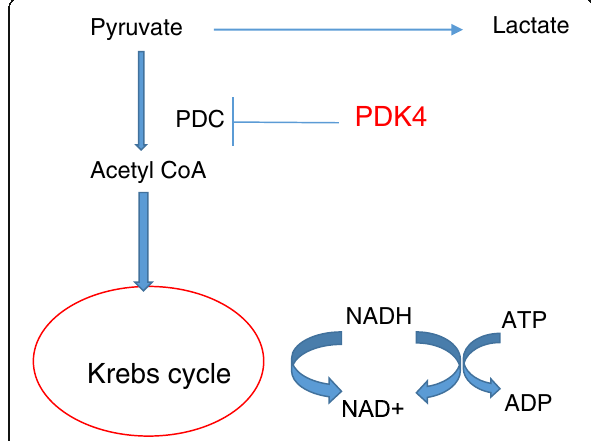
Fig. 4 PDK4 is the key regulator of pyruvate entry into the Krebs cycle. Increased expression of PDK4 would inhibit or block entry of pyruvate into the Krebs cycle or oxidative metabolism. Our data suggests that this occurs in heart failure pre and post LVAD